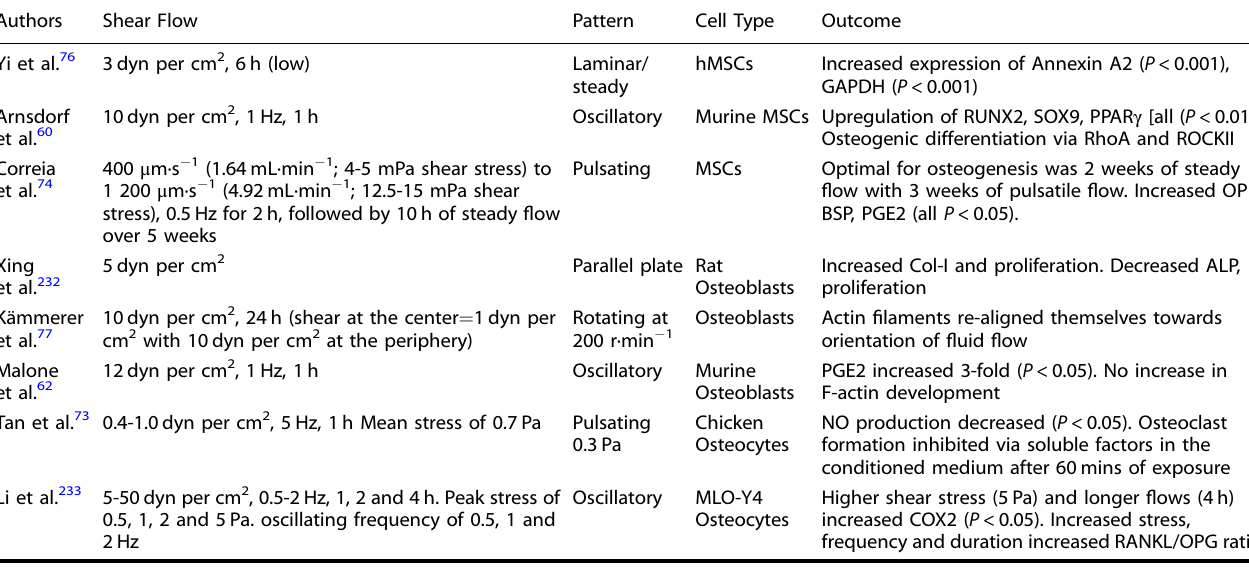
Table 1. Studies are presented in increasing order of shear stress and according to cell